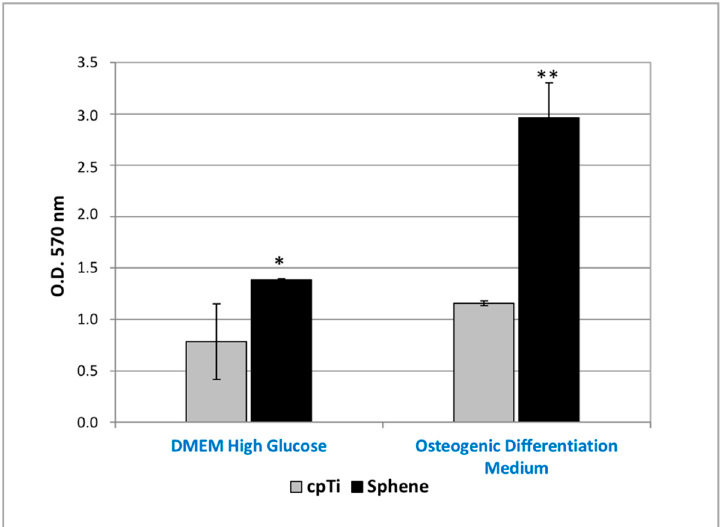
Figure 5. MTT assay of hADSCs cultured for 21 days on uncoated cpTi samples ( cpTi ) and on sphene-coated ( Sphene ) samples in DMEM High Glucose or Osteogenic Differentiation Medium. * p < 0.05, ** p < 0.01, *** p < 0.001.